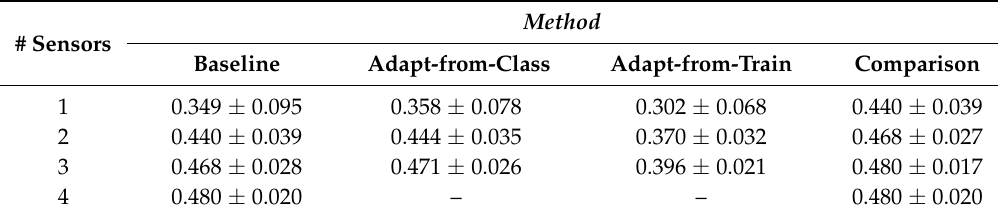
Table 1. Mean F-scores on test data for each number of sensor in the form mean ± standard deviation.